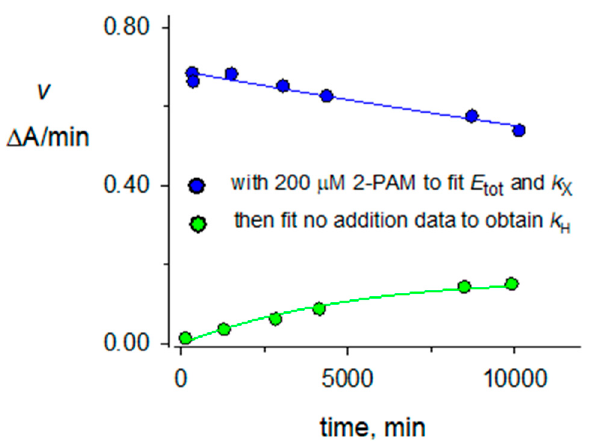
Figure 4. Denaturation and hydrolysis of diethylphosphorylated AChE in D 2 O. A mixture of 2.0 µ M paraoxon and 1.4 µ M AChE in 100 mM sodium phosphate and 0.1% BSA (bu ff er) in D 2 O (pH 8.0) was incubated for 70 min at 25 ◦ C. A 4-fold excess of bu ff er in D 2 O was added, and 200 µ L was applied to a 0.5 mL Sephadex G50 spin column (Fisher) that had been prewashed four times in bu ff er in D 2 O and centrifuged at 1000 × g for 1 min. The eluent was cooled to 4 ◦ C, and 60 µ L was added either to 640 µ L of bu ff er in D 2 O at 25 ◦ C or 640 µ L of the same bu ff er with 2-PAM (to 200 µ M) at 25 ◦ C. Aliquots (30 µ L) were assayed as in Figure 3 at the times indicated on the x -axis. Assay values v for the solution containing 2-PAM (blue points that correspond to enzyme denaturation) were first fit to Equation (2) with t aged set to 0 and fixed initial estimates (min − 1 for k values) of k A = 4 × 10 − 5 , k H = 4 × 10 − 5 , k r = 2 × 10 − 2 and E 0 = 0.01 ∆ A / min to obtain k X = 2.2 × 10 − 5 and E tot = 0.69 ∆ A / min. These values of t aged , k A , and E tot along with k X = 4 × 10 − 5 and k r = 0 were then fixed into Equation (2) to fit the assay values v for the solution without 2-PAM (green points that reflect enzyme denaturation and diethylphosphorylated enzyme hydrolysis). This fitting gave E 0 = 0.003 ∆ A / min and a k H value of (47 + 3) × 10 − 6 min − 1 included in Table 1.